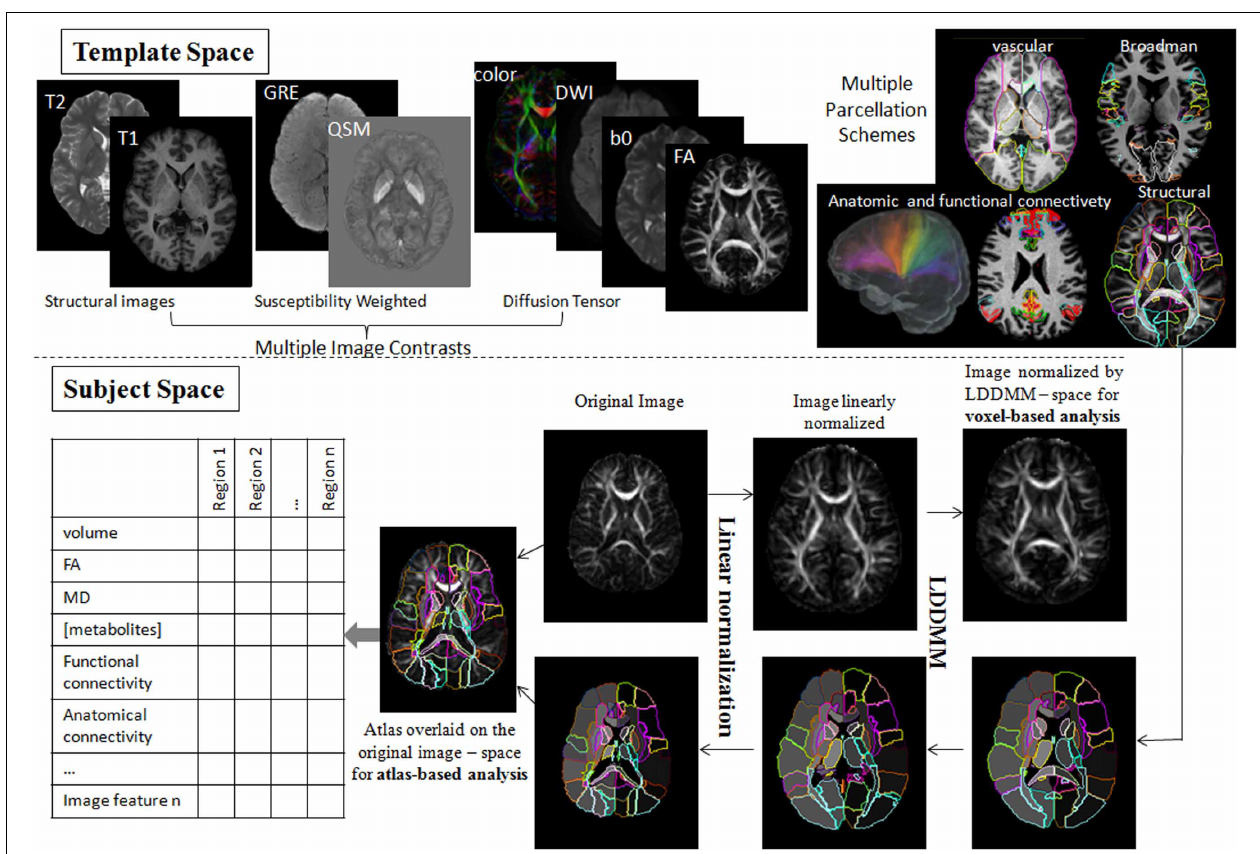
FIGURE 4 | Showing the pipeline starting with the modalities in atlas coordinates (top row) with the DiffeoMap applied to the target showing the parcellation of target modalities (bottom row). The algorithm used for solving for the multi-modality DiffeoMap is multi-modality LDDMM.